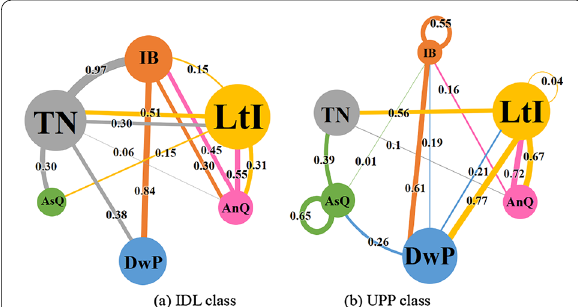
Fig. 3 Transitional network representation in learners’ behavior from two instructional modes. A node represents a behavior code, the node size represented the frequency of the code, the width represented the transitional value, a Yule’s Q value, and the direction should be read from the node with the same color of the line to the node with a different color